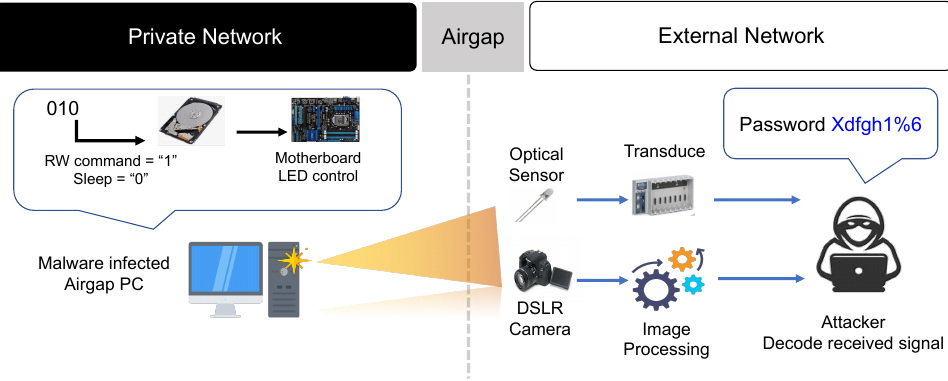
Figure 8. Conceptual diagram of air-gap attack using hard disk drive LED